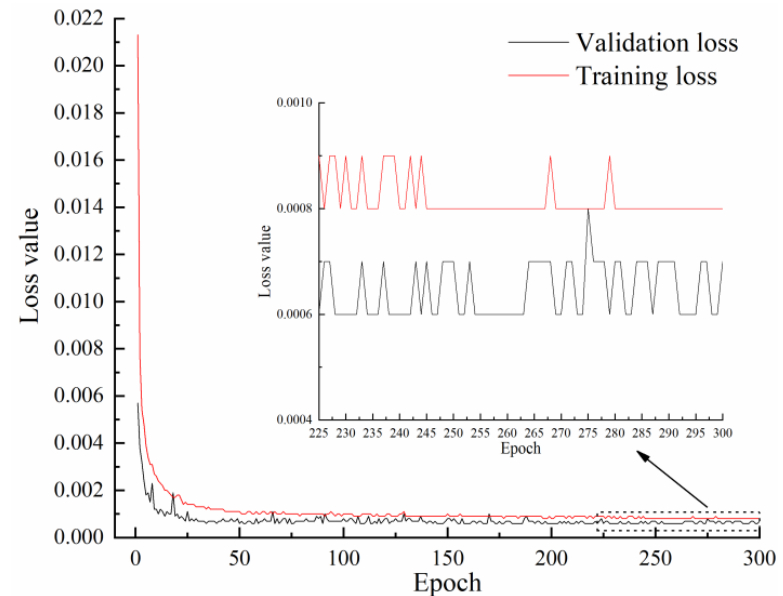
Figure 6. Change of loss value during